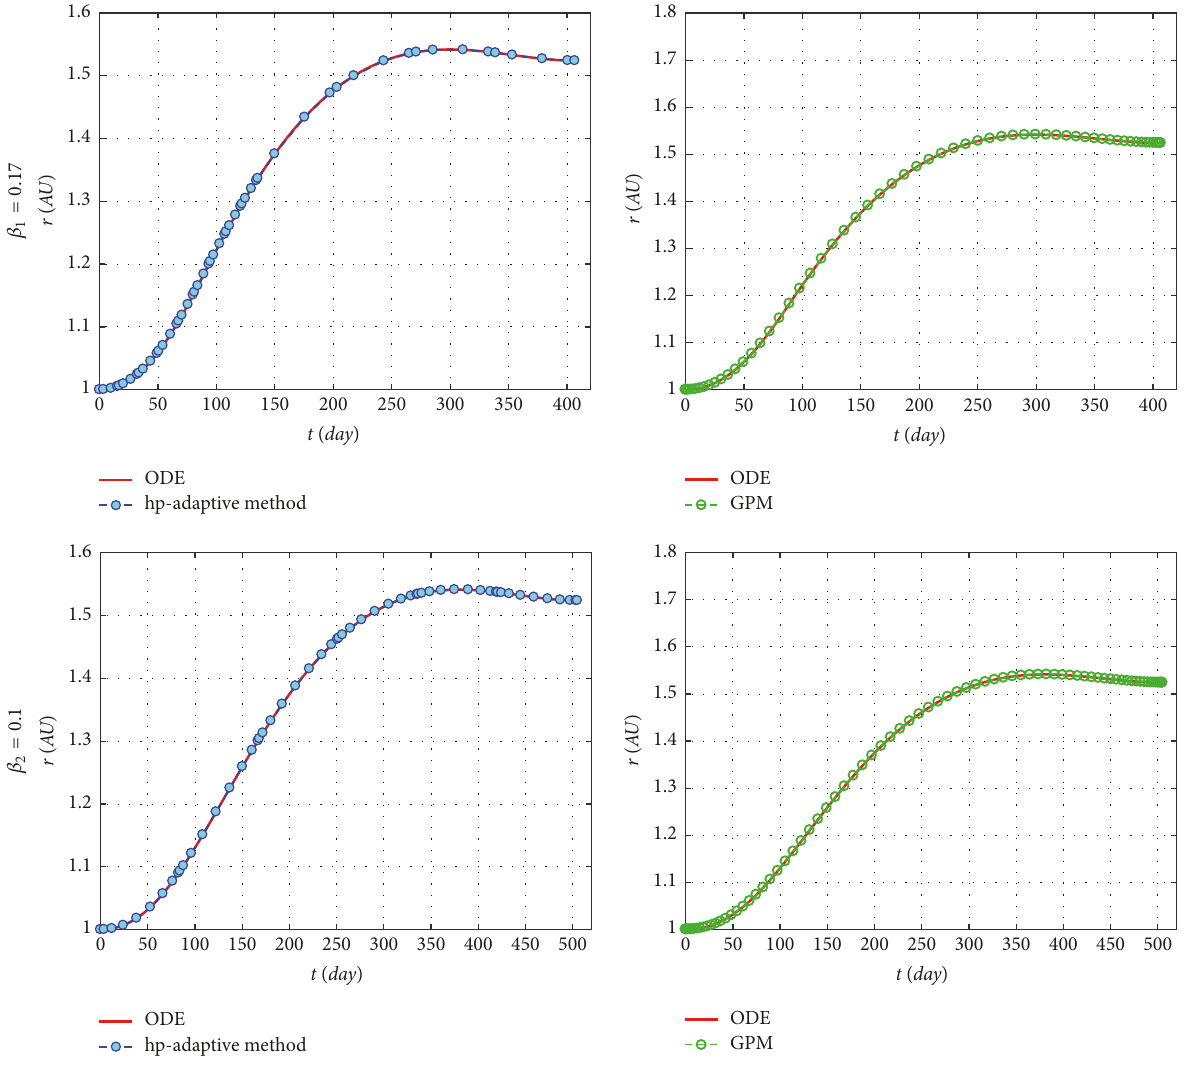
Figure 5: The variation curve of orbit transfer